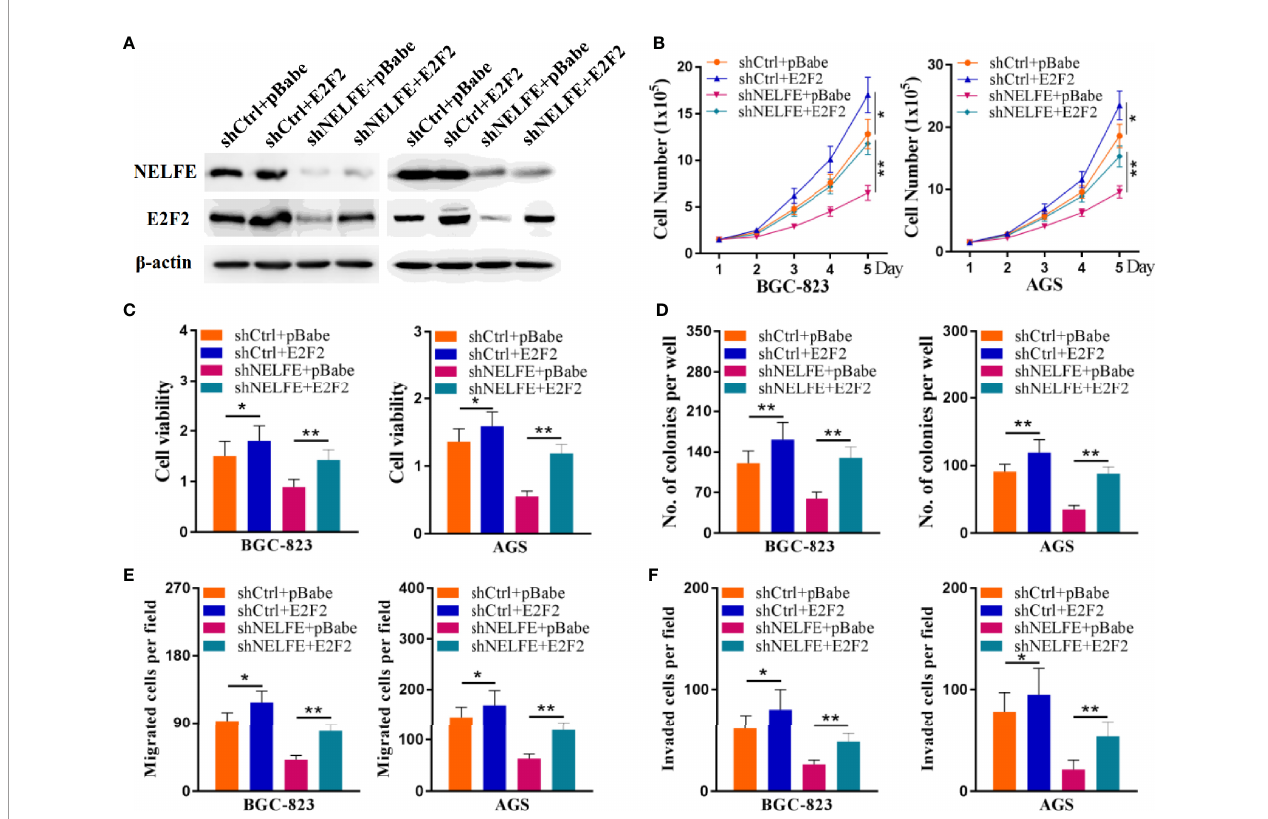
FIGURE 6 | E2F2 overexpression reversed the cancer-promoting effect of NELFE. Overexpression of E2F2 plus knockdown of NELFE rescues the phenotype induced by NELFE knockdown. (A) The restoration of E2F2 expression in BGC-823 and AGS cells was con fi rmed by western blotting. (B) , Proliferation curves of BGC-823 and AGS cells transfected with the control shRNA plus pBabe, shRNA plus E2F2, sh-NELFE plus pBabe and sh-NELFE plus E2F2. (C, D) MTT and colony formation assays of BGC-823 and AGS cells transfected with the control shRNA plus pBabe, shRNA plus E2F2, sh-NELFE plus pBabe and sh-NELFE plus E2F2. (E) Transwell migration and (F) invasion assays of BGC-823 and AGS cells transfected with the control shRNA plus pBabe, shRNA plus E2F2, sh-NELFE plus pBabe and sh-NELFE plus E2F2. *P < 0.05, **P <